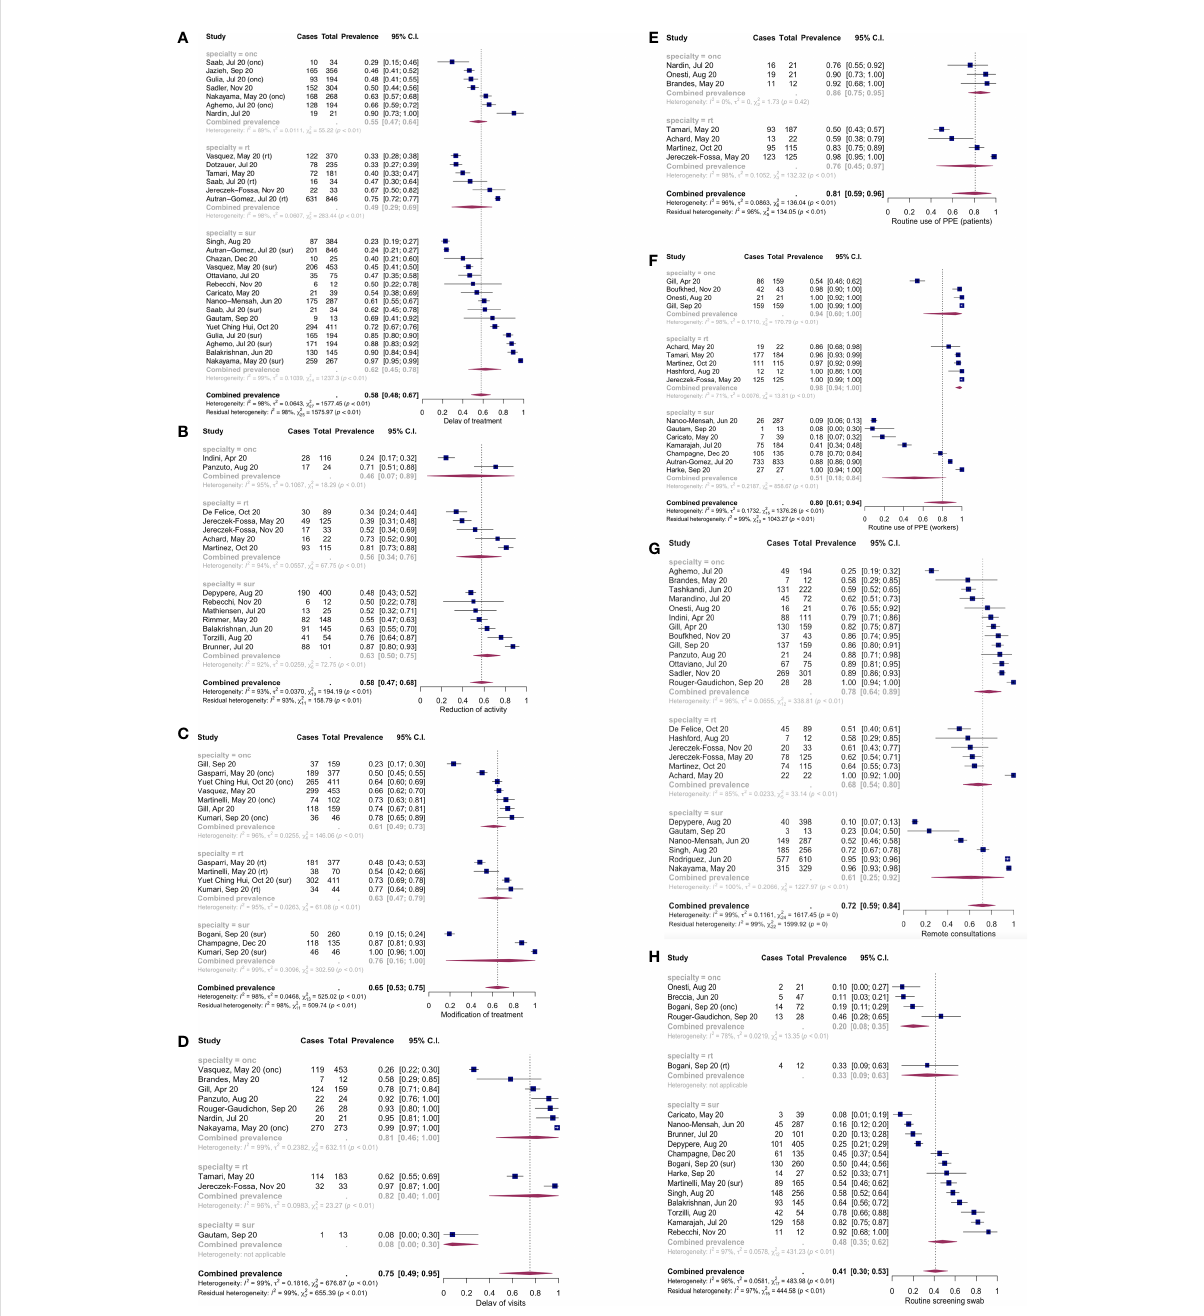
FIGURE 3 Forest plots of the meta-analysis results for the 8 outcomes. (A) Treatment delay/cancellation; (B) Reduction of activity; (C) Modi fi cation of treatment; (D) Delay of visits; (E) Routine use of PPE (patients); (F) Routine use of PPE (workers); (G) Use of remote consultations; (H) Routine screening SARS-CoV-2